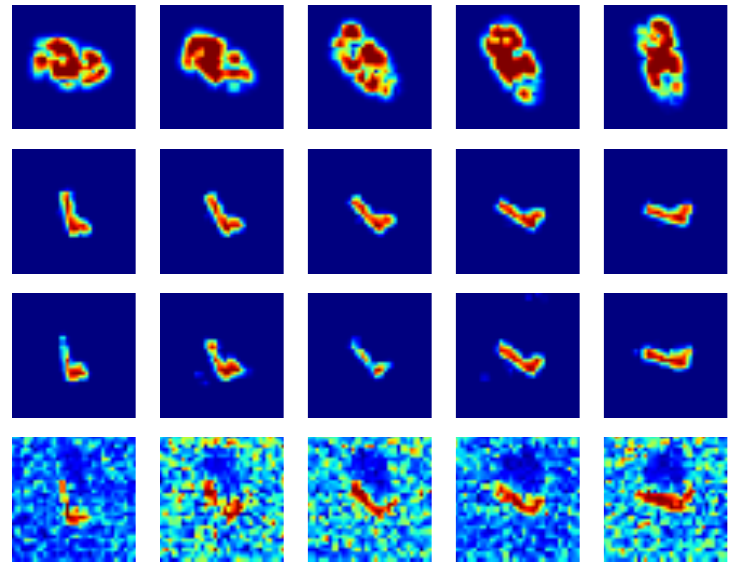
Figure 4. Illustration of SAR image samples from four datasets considered in the experimental setup: simulated SAR images with different viewing angles (top row); a radar image from the MSTAR dataset, with suppressed background, rotated for various angles (second row); SAR images from MSTAR dataset corresponding to different viewing angles of the same target, with suppressed background (third row); SAR images from MSTAR dataset corresponding to different viewing angles with a background (bottom